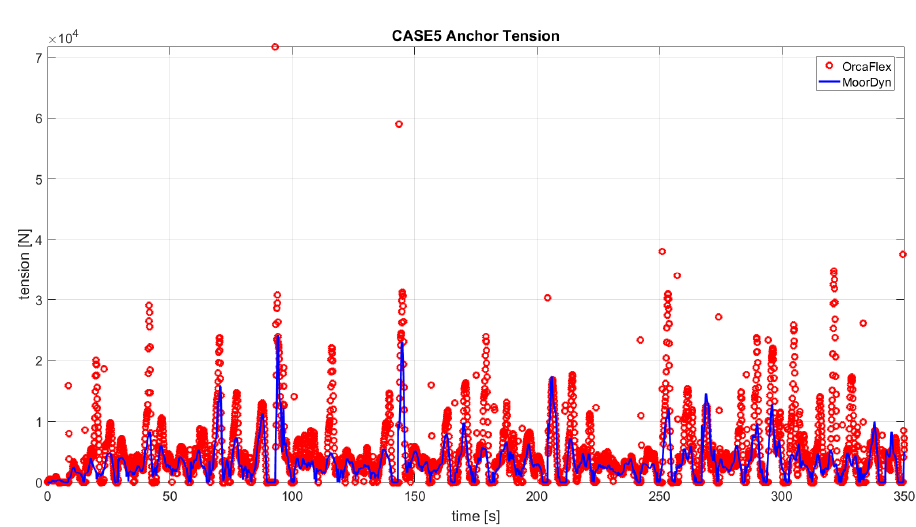
Figure 19. Simulation case 5: Time series of anchor tension.